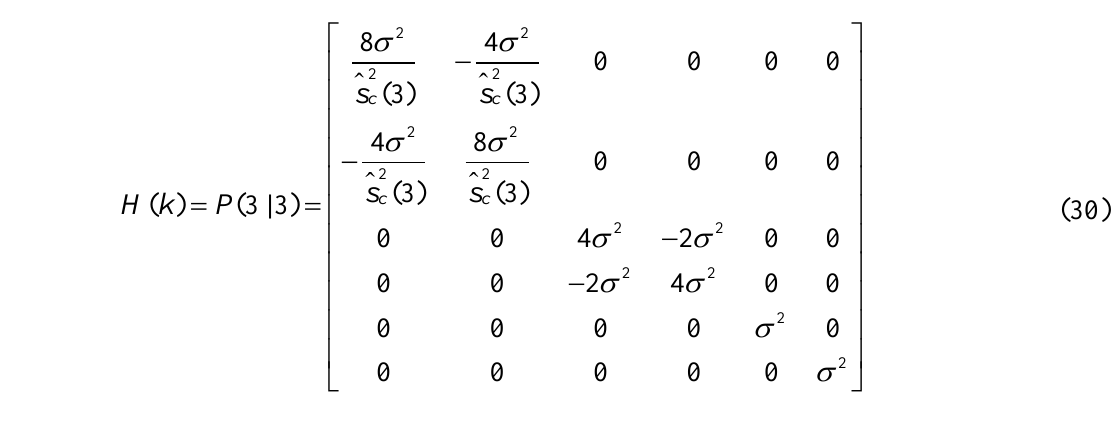
Table 1. Summary of the recursive filtering